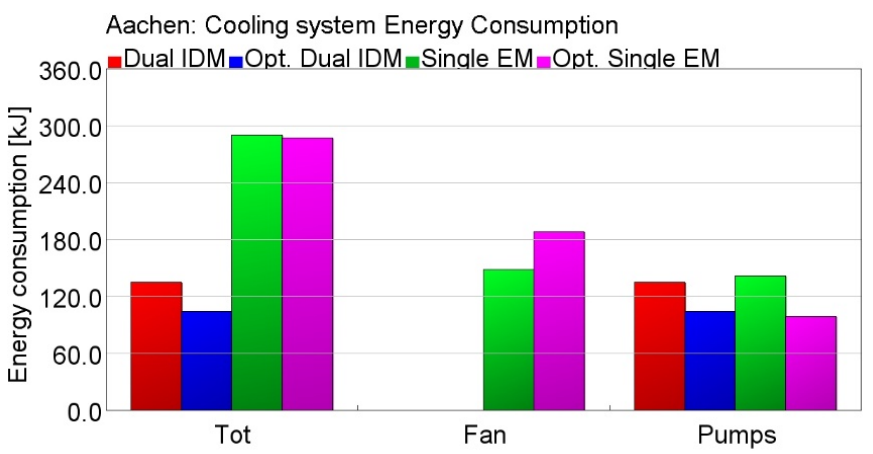
Figure 25. Impact of modularity and optimized control strategy on the energy consumption reduction for the Aachen driving cycle.